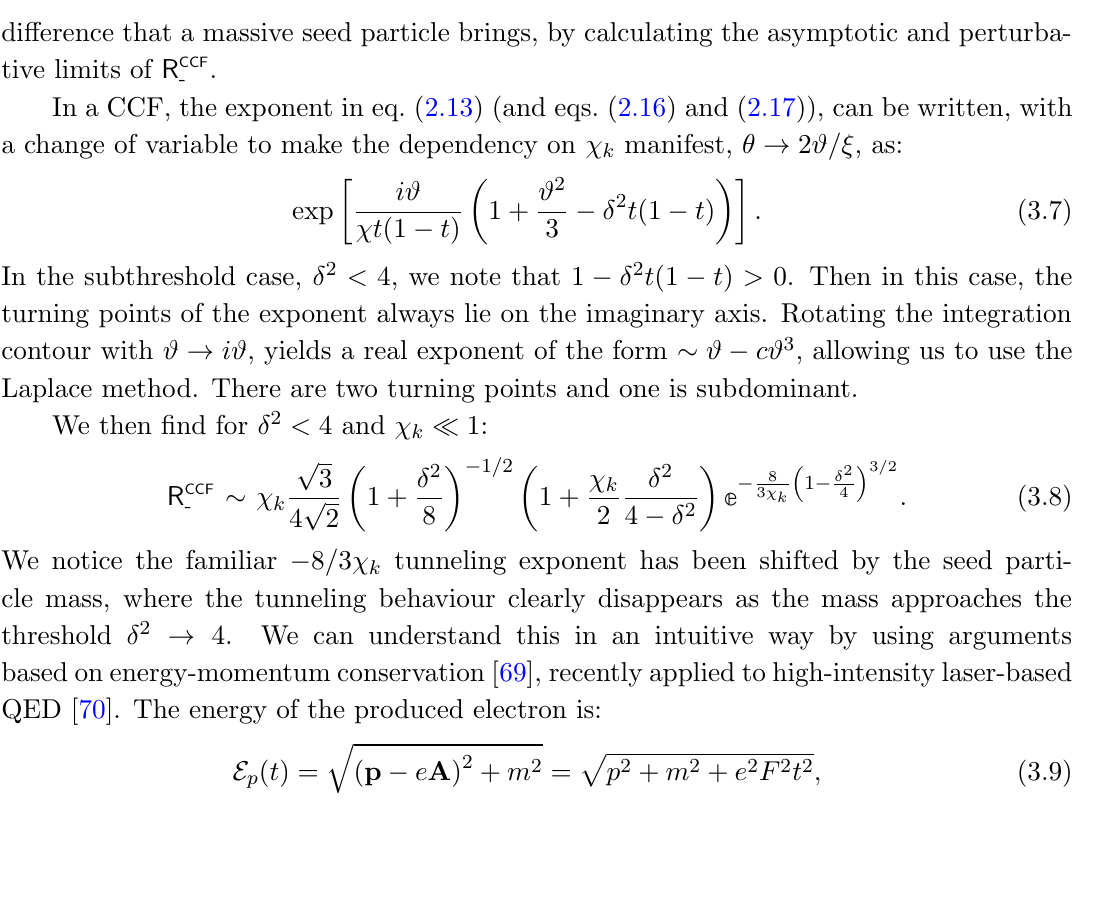
Figure 2 . Plots of R CCF for various seed-particle masses. a) the e(cid:11)ect of the threshold when (cid:31) k (cid:28) 1 - | exponential suppression below the threshold and an oscillatory dependence on (cid:14) 2 above it. b) for small (cid:31) k , when the decay is above-threshold, the probability oscillates about the vacuum values (shown as grey horizontal lines) and in the below-threshold regime, the probability is exponentially suppressed. For large (cid:31) k , the distinction between above- and below- threshold is lost and the dependence on particle mass disappears. In b), black solid lines are the asymptotic results, which become more accurate for heavier masses and smaller (cid:31) k